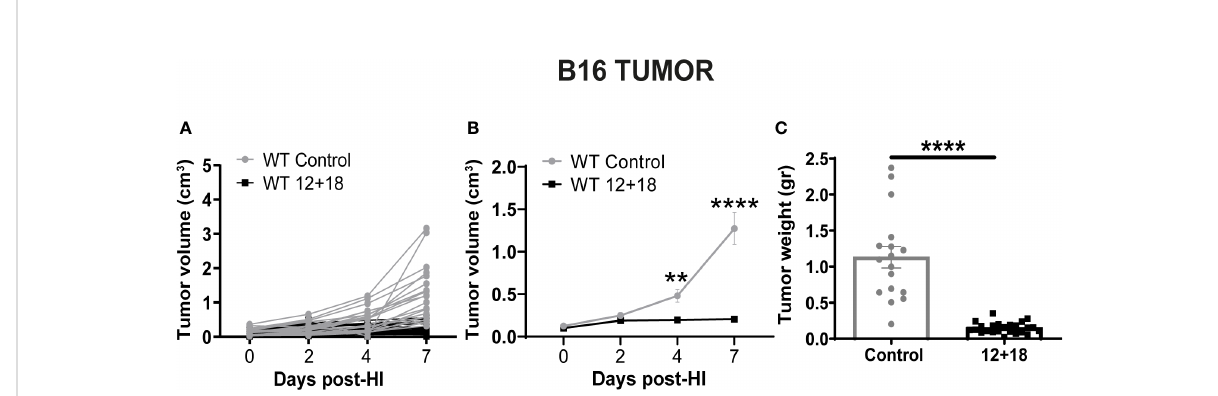
FIGURE 1 Effects of the systemic co-expression of IL-12 plus IL-18 on tumor growth. B16-bearing C57BL/6 WT mice were hydrodynamically injected (HI) with IL- 12 plus IL-18 cDNA (12 + 18) or empty cDNA as the control. At the indicated time points post-HI tumor size was measured using a caliper. After 7 days post-HI mice were euthanized, and tumors were harvested and weighed using an analytical scale. (A, B) Tumor growth represented as tumor volume (in cm 3 ) at speci fi ed days post-HI is shown (A) for each mouse individually or (B) as an average (mean ± SEM) for each group. (C) Tumor weight in grams is represented as mean ± SEM for each experimental group. Statistical analysis was performed using a two-way ANOVA with Sidak ’ s multiple comparison test on (B) or a Student T test in (C) . Values of **p<0.01, and ****p<0.0001 were consider signi fi